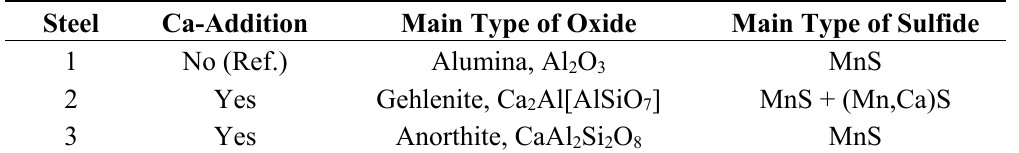
Table 6. Types of main inclusions in experimental trials of AISI 316L stainless steel [42]. Steel Ca-Addition Main Type of Oxide Main Type of